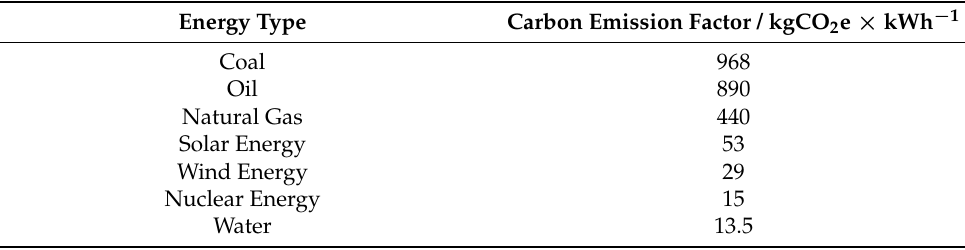
Table 1. CEF of common electric energy sources.